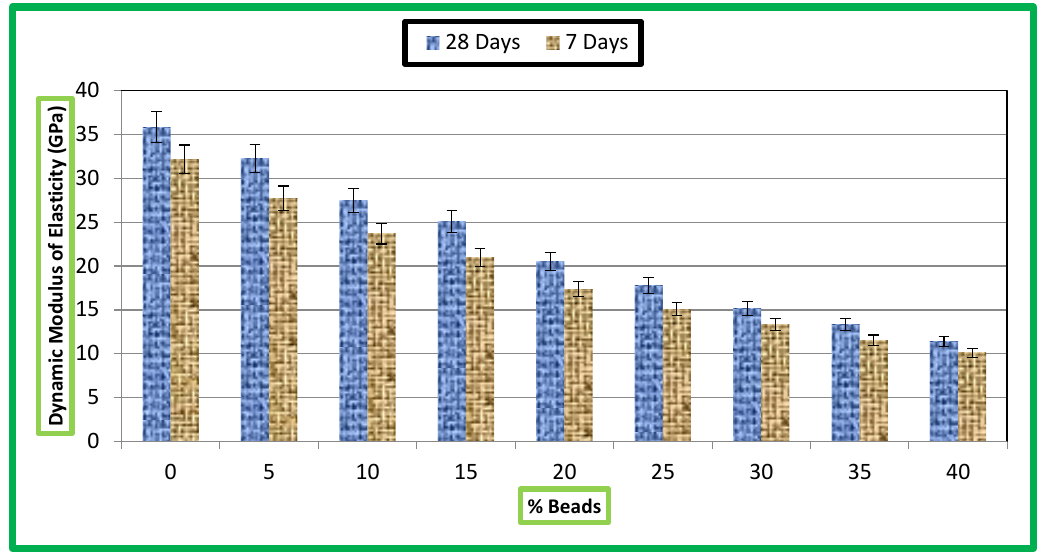
Figure 23. Relationship between percentage beads and Ed at 7 and 28 days.